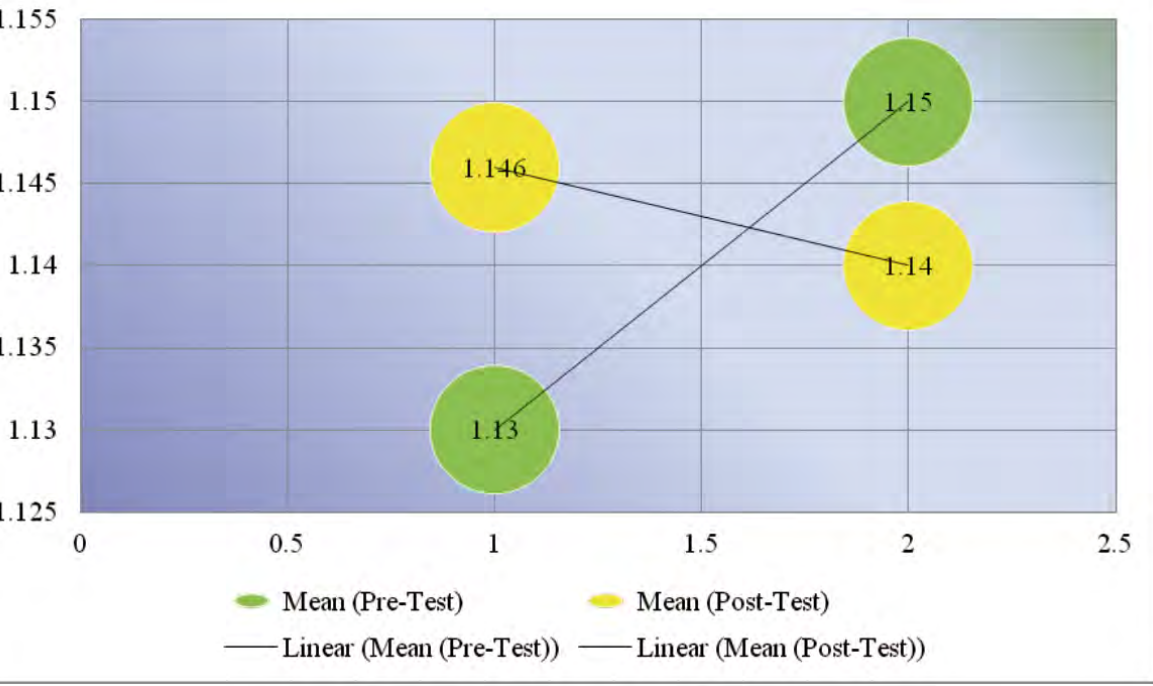
Fig. 4. Mean values of Bone Integrity in Experimental and Control group (n=15 each) before (Pre) and after (Post) 4- weeks Bhastrika Pranayama Training Programme (Experimental group